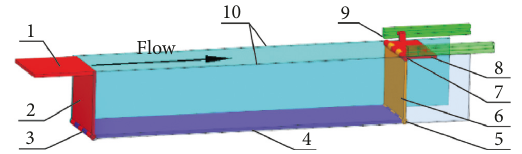
Figure 1: Three-dimensional schematic of a deformable cavity.